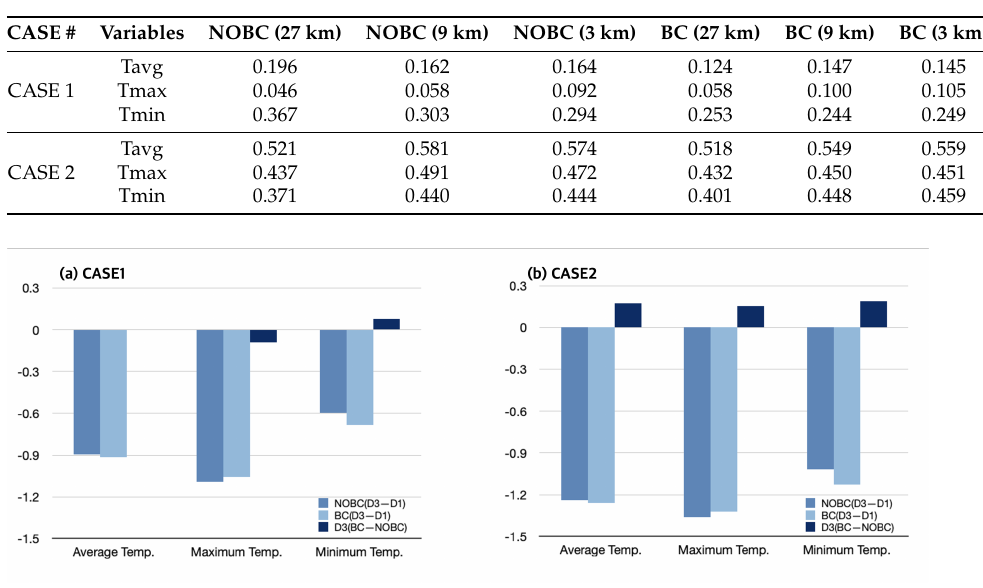
Figure 9. The difference in RMSEs between Domain 1 (27 km, D1) and Domain 3 (3 km, D3) and between the NOBC and BC experiments at